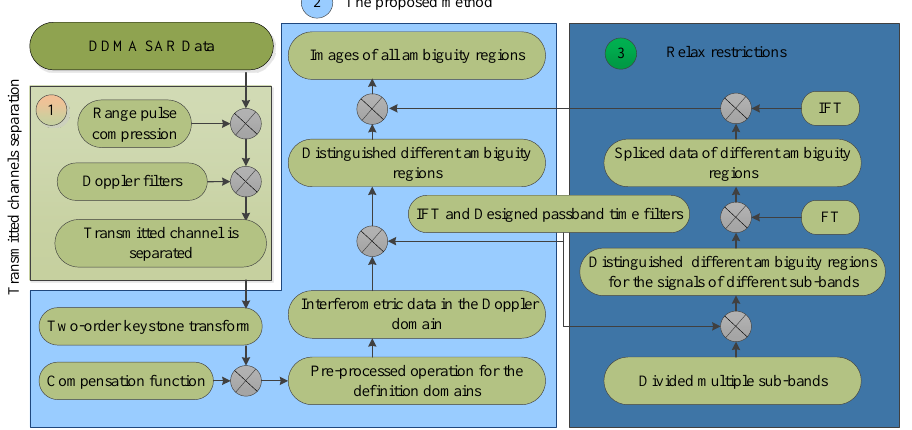
Figure 6. Block diagram of the proposed method.